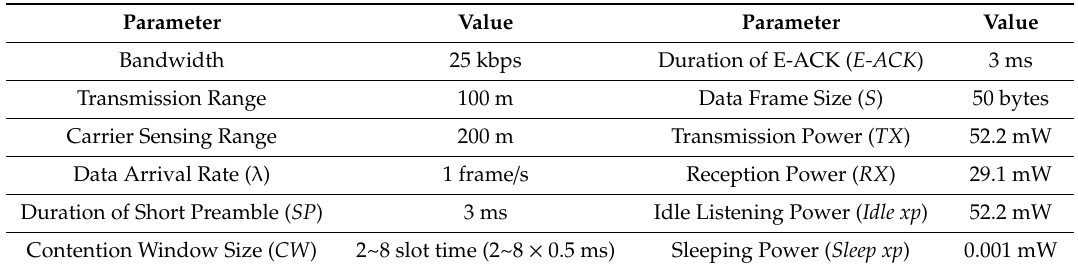
Table 3. Experiment